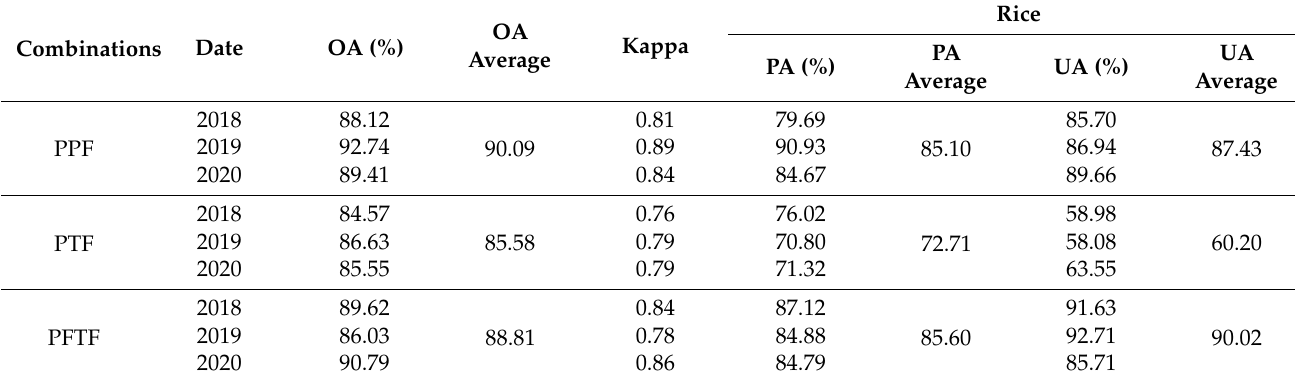
Table 9. Accuracy of rice mapping with randomly picked SAR